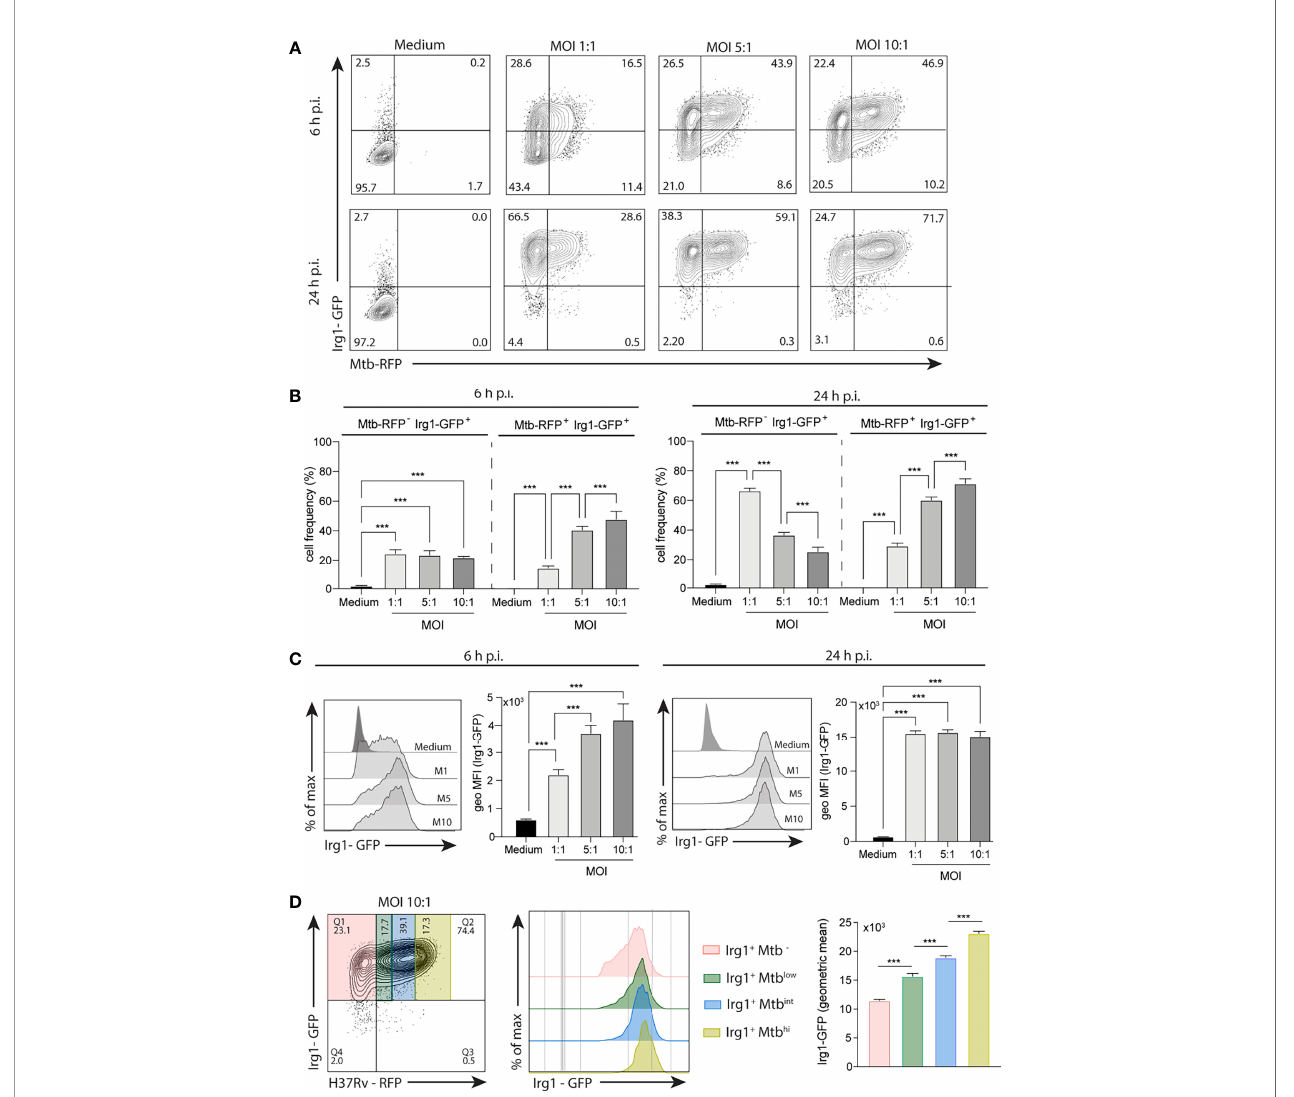
FIGURE 1 | Mtb induces Irg1 protein expression in macrophages. BMDMs obtained from transgenic mice expressing Irg1-GFP protein (Irg1-GFP + ) were infected with H37Rv-RFP at different MOI (1:1; 5:1; 10:1) as indicated. (A, B) Mtb-induced Irg1-GFP expression was evaluated by fl ow cytometry at 6 h and 24 h p.i. (A) Sample FACS plots and (B) frequency of macrophages expressing Irg1-GFP are shown. (C) Histogram FACS plot and geometric MFI of Irg1-GFP was evaluated by fl ow cytometry at 6 h (left) and 24 h (right) p.i. (D) FACS plot and histogram of Irg1-GFP expression in cells displaying low, intermediate and high MFI of RFP. Statistical signi fi cance was assessed by one-way ANOVA analysis for the indicated experimental condition (***p < 0.001). The data shown are from a representative experiment of two